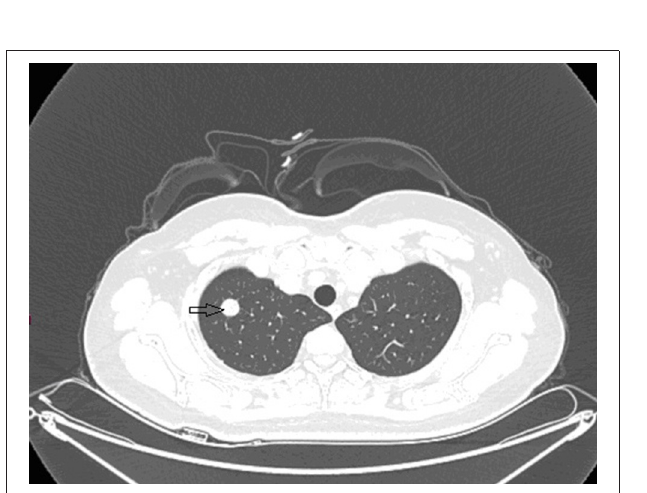
FIGURE 6 | Contrast-enhanced CT images at 18 months after second surgery: lump in upper lobe of the right lung.